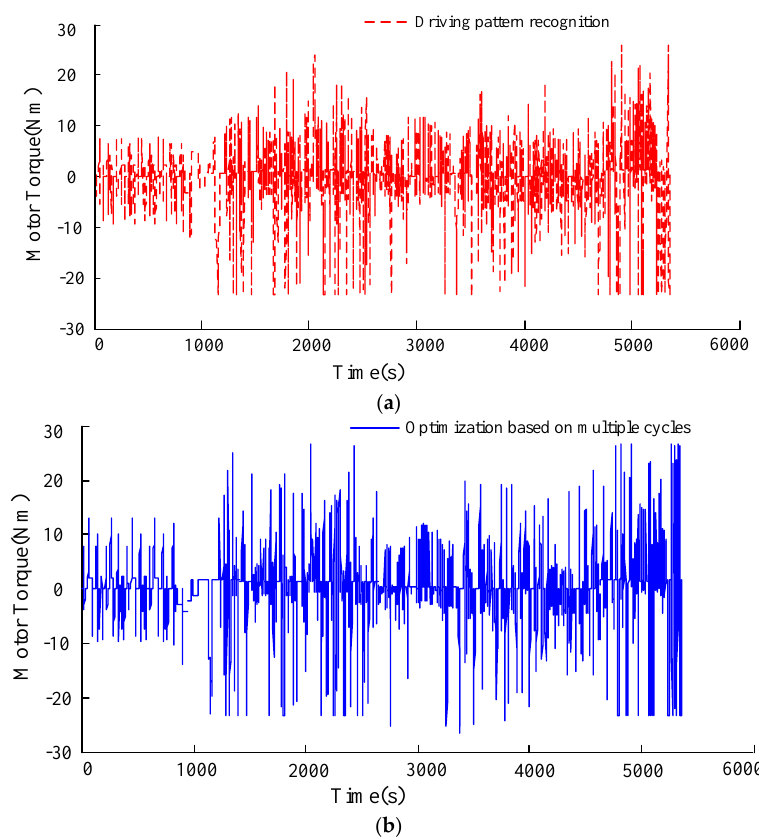
Figure 15. Engine power under the comprehensive driving cycle. ( a ) Engine power based on driving pattern recognition; ( b ) engine power based on multiple driving cycle optimization.